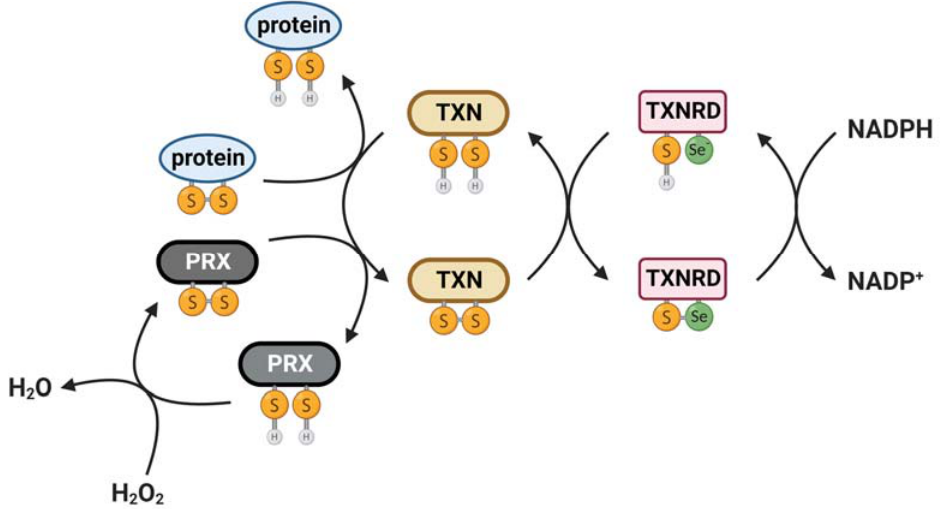
Figure 1. Role of thioredoxin system in antioxidant defense. Thioredoxin (TXN) catalyzes the reduction of disulfides (S-S) within oxidized cellular proteins, which can act to restore protein function. An important target of thioredoxin is the antioxidant peroxiredoxin (PRX), which can detoxify hydrogen peroxide. In reducing target proteins, thioredoxin becomes oxidized. In order to reactivate thioredoxin, thioredoxin reductase (TXNRD) reduces TXN using reducing equivalents obtained from NADPH. S-S = oxidized form. SH = reduced